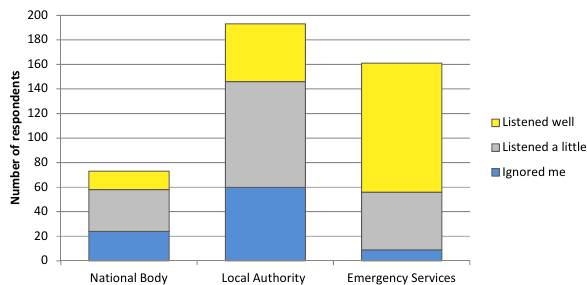
Fig. 8. Trust in public agencies in Ireland and Scotland ( n = 580; non-response = 1).